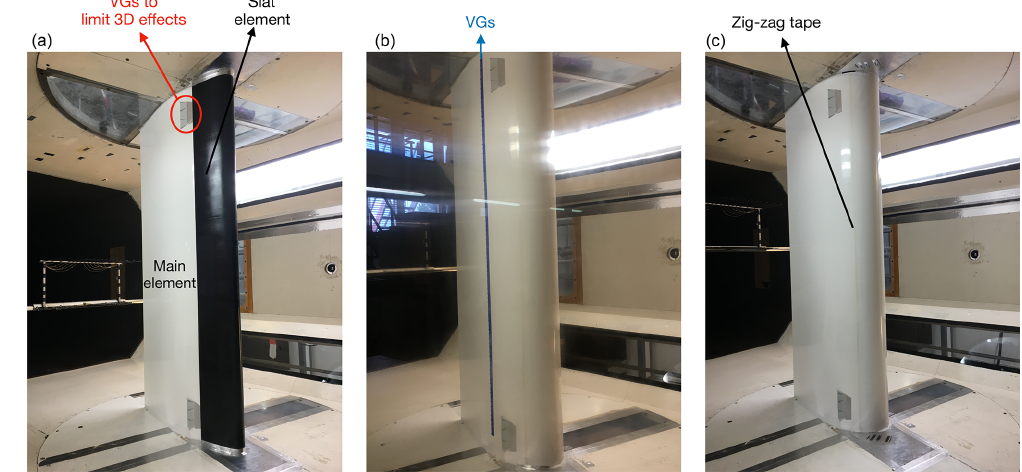
Figure 3. Photographs of the experimental setup: main profile with slat element (a) , main profile with vortex generators (b) , and main profile with zig-zag tape (c) . In all the cases, VGs are used close to the walls to limit three-dimensional effects. This is highlighted in red on the left picture.